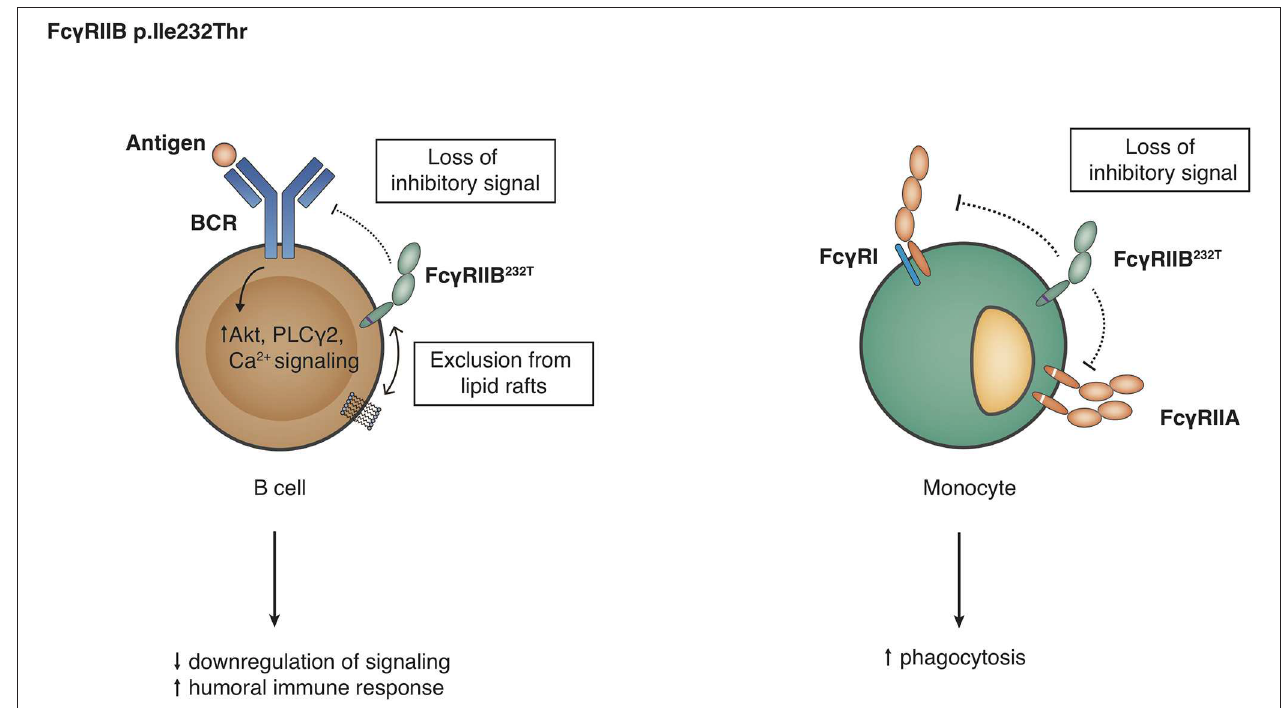
FIGURE 5 | Functional consequences of the FCGR2B- p.Ile232Thr variant. Detailed explanations are given in the main text.